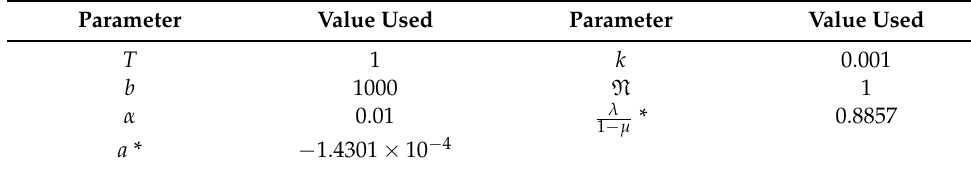
Table 7. Acquisition parameters for Google stock.